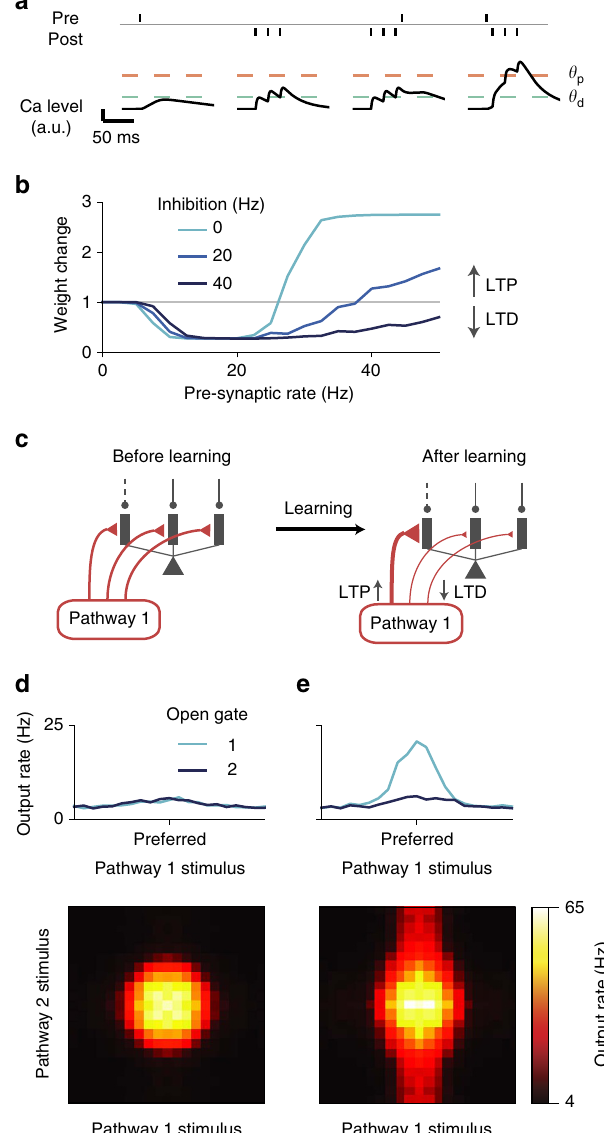
( c ) Learning paradigm. Left: excitatory synapses from each pathway are initialized uniformly across dendrites. When pathway 1 is activated, specific branches of the neuron are disinhibited (dashed line), that is, gate 1 is open. During learning, only one pathway is activated at a time. Right: after learning, activated excitatory synapses onto the disinhibited branches are strengthened, while activated synapses onto inhibited branches are weakened, resulting in an alignment of excitation and disinhibition patterns. Synaptic weights of non-activated synapses remain unchanged (not shown). ( d ) Response properties of the neuron before learning. Top: tuning curve of the neuron when only pathway 1 is presented. The neuron shows no preference to the gate opened prior to learning. Bottom: two- dimensional tuning curve of the neuron when both pathways are simultaneously presented and gate 1 is open. See Fig. 2 for the definition of the tuning curves. ( e ) Response properties of the neuron after learning. Top: the neuron shows strong tuning to pathway 1 input when gate 1 is open. Bottom: when both pathways are presented, the neuron’s response is primarily driven by pathway 1 stimulus, although pathway 2 stimulus also affects the neuron’s